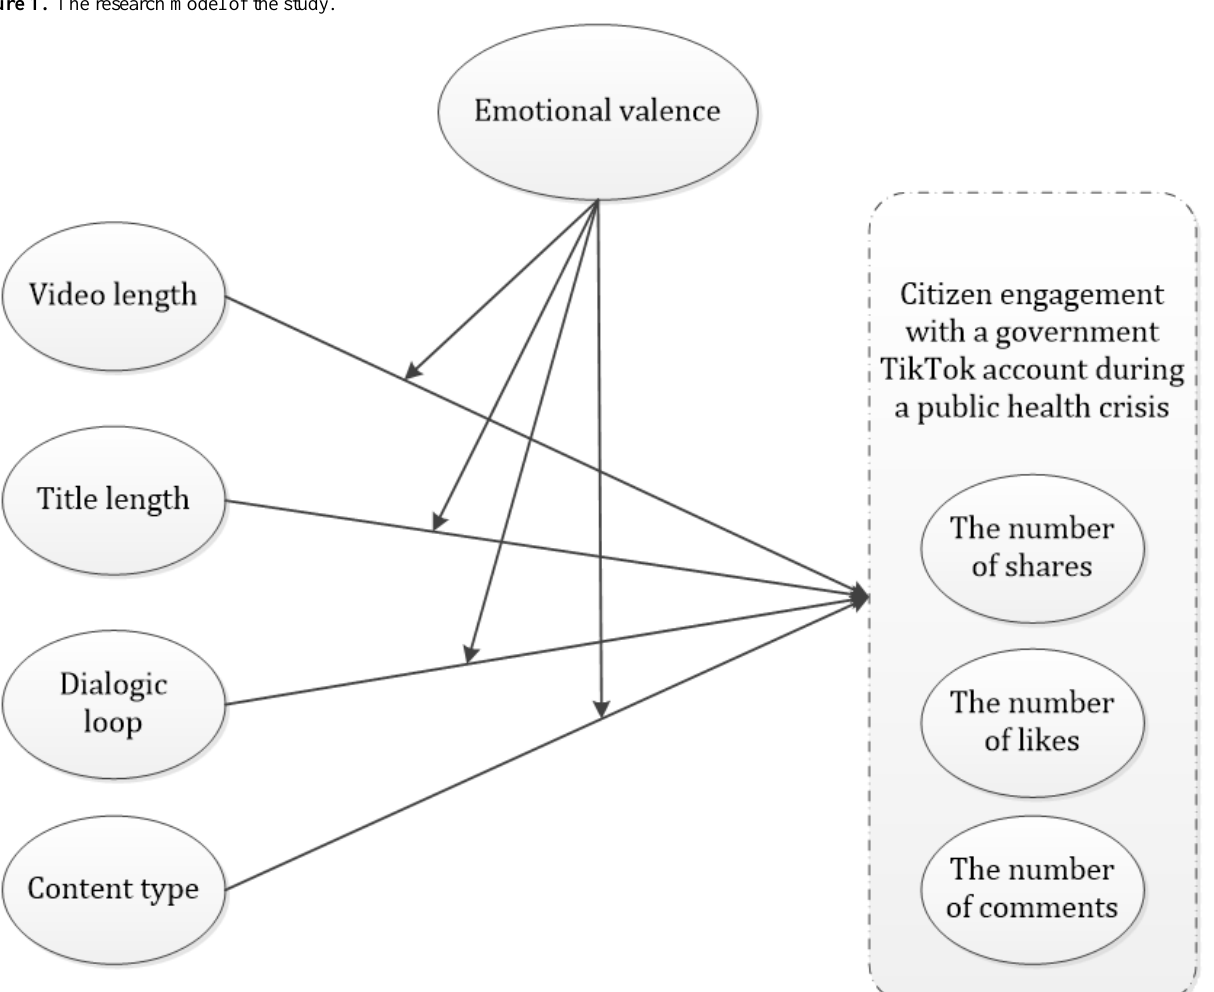
Figure 1. The research model of the